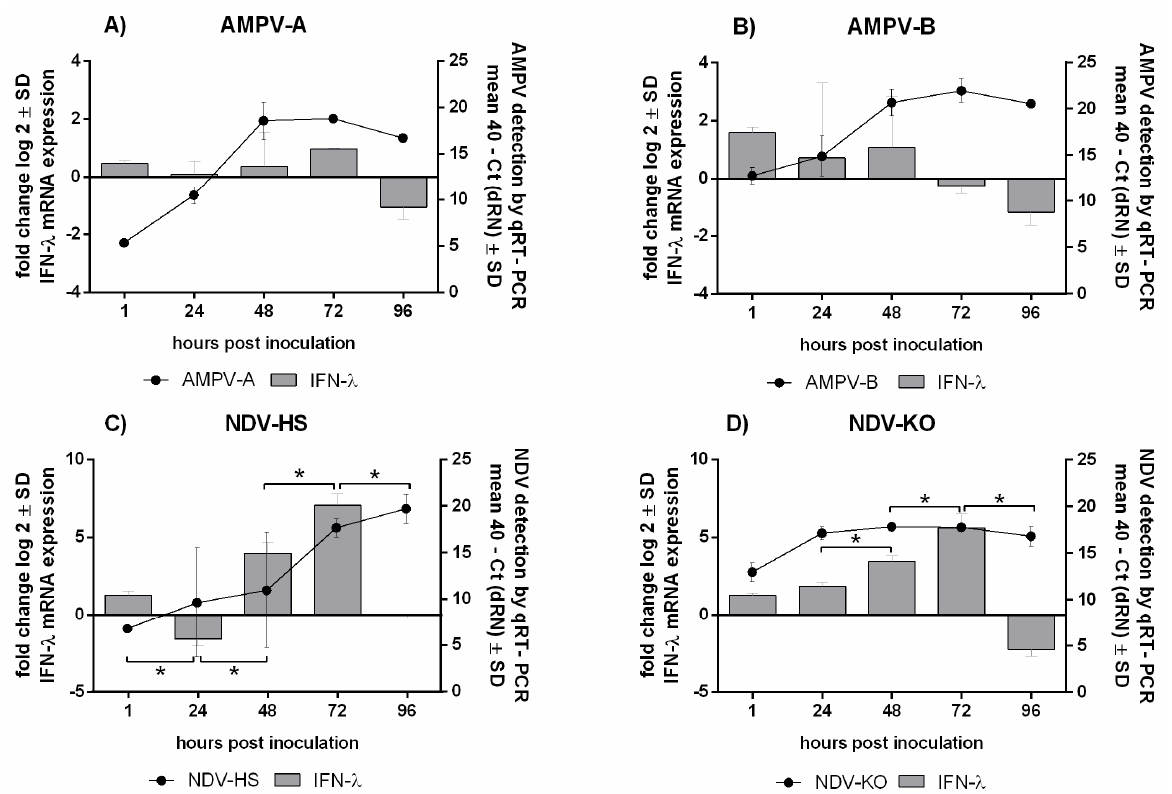
Figure 7. Quantification of IFN- λ mRNA expression in correlation with AMPV and NDV replication in OOCs. ( A ) AMPV-A, ( B ) AMPV-B, ( C ) NDV-HS, and ( D ) NDV-KO. Three rings/group/time points were investigated. Error bars indicate standard deviations. * indicate signi fi cant di ff erences between the virus-inoculated group and the virus-free group at the same time point, determined